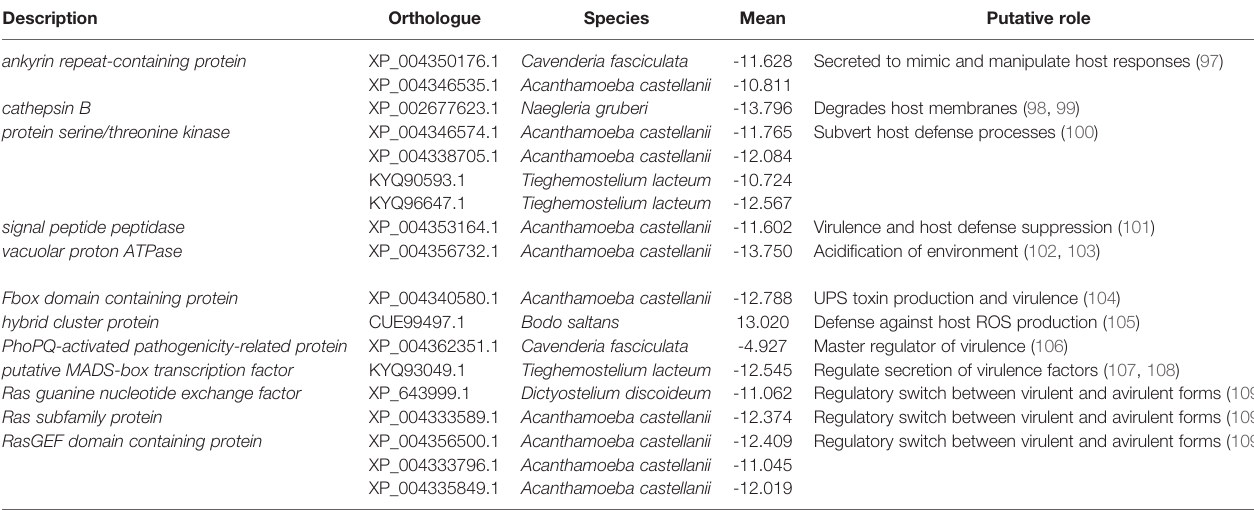
TABLE 4 | Selected genes differentially expressed (fold change > 2; P < 0.05) in Neoparamoeba perurans in the pathogenesis of amoebic gill disease in Atlantic